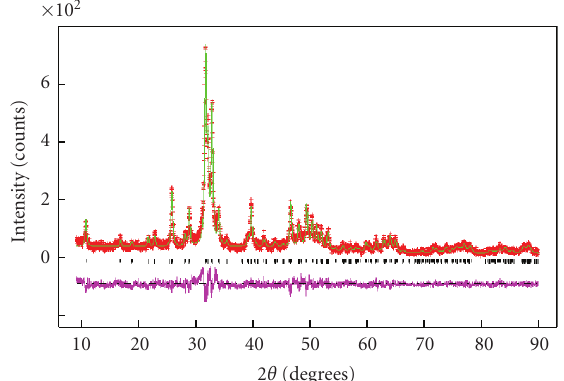
Figure 3: Rietveld refinement of the di ff raction pattern collected from the sample T38. Crosses mark the experimental data, the continuous line is the calculated HAp pattern, the vertical ticks mark the calculated Bragg peaks, and the lower trace shows the di ff erence between observed and calculated patterns.